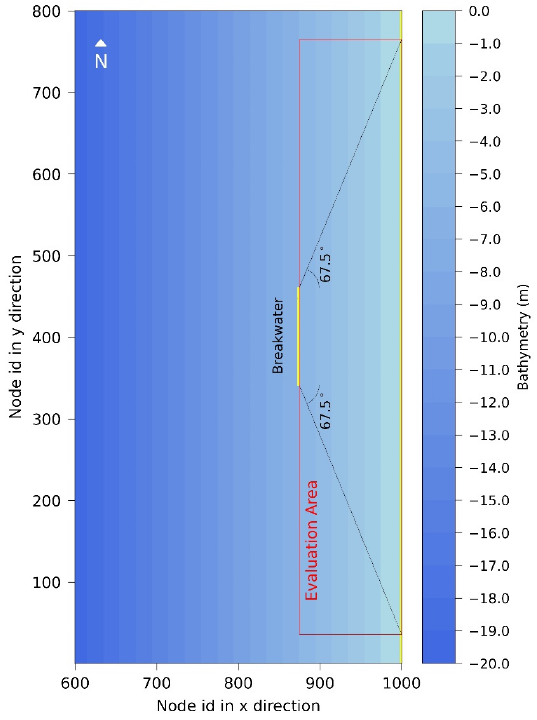
Figure 3. Selected overview of the bathymetry of the idealized case, evaluation area of the BSS (enclosed in the red rectangle). The shadow area of the breakwater is denoted by the black lines.